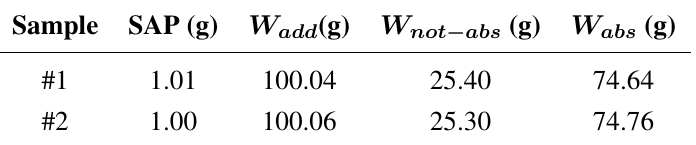
Table 2. Summarized results of the experiment for assessing the absorption capacity of the